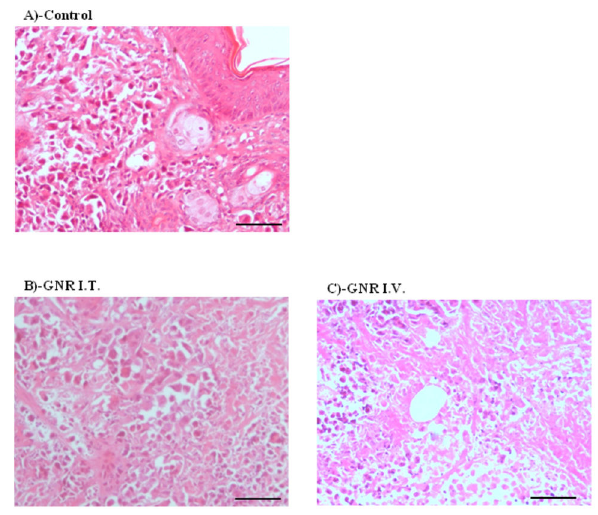
Figure 6. Histological examination for EACC solid tumor treated with gold NRs coupled with laser induced photo plasmonic thermal therapy. EACC tumors of control group (A); gold NRs IT treated group (B); and IV treated group (C) were stained by H&E regular stain. GNR coupled with PTT showed massive tissue destruction appeared as non-cellular debris eosinophilic areas (arrows) Scale bar = 20 µm. doi: